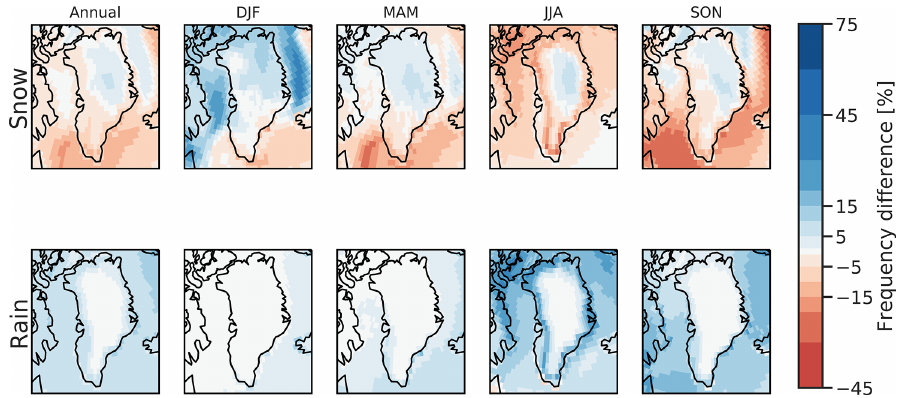
Figure 9. Annual (left) and seasonal (DJF, MAM, JJA, SON, from left to right) mean snowfall (top) and rainfall (bottom) frequency difference from present to future over the Greenland Ice Sheet simulated by CESM (present: 2006–2020 and future: 2080–2095).